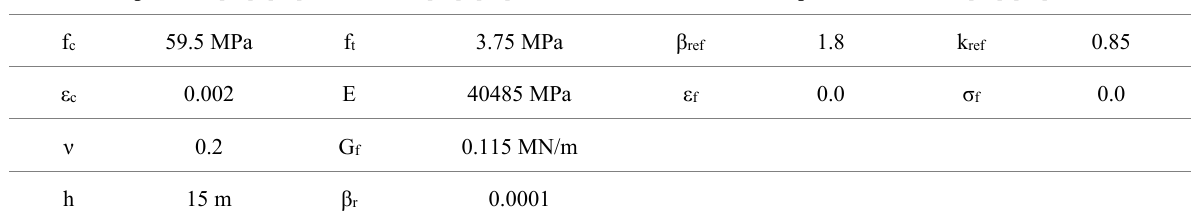
Table 3. Material parameters: three-point bending